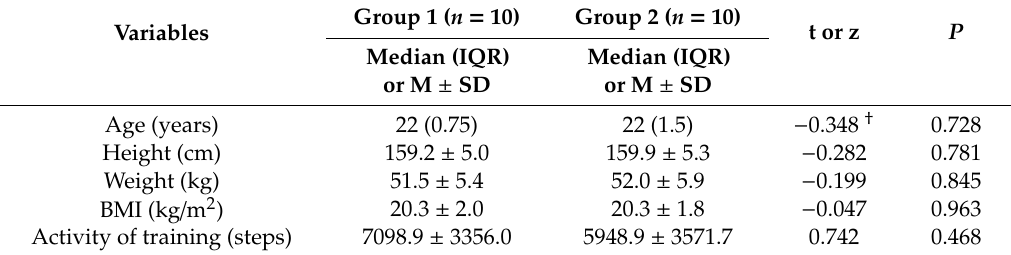
Table 1. Basic characteristics and homogeneity tests between